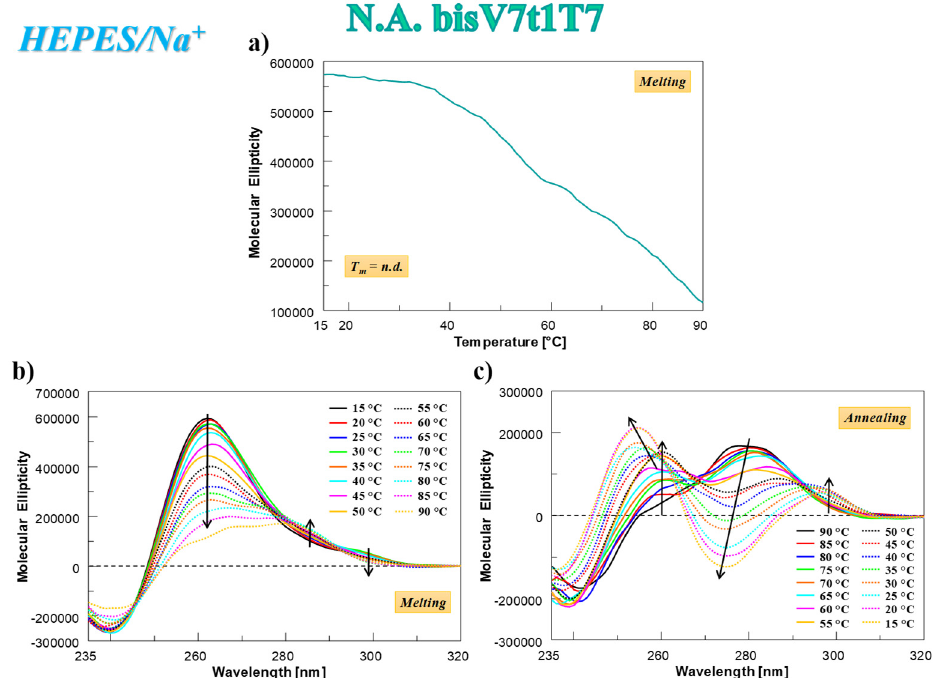
Figure 4. N.A. bisV7t1T7 at 2 μ M concentration in the selected HEPES/Na + buffer: ( a ) CD-melting profile, recorded at 262 nm using a scan rate of 1 °C/min; ( b , c ) overlapped CD spectra recorded every 5 °C during the melting ( b ) and cooling processes ( c ). Arrows in panels b and c indicate the evolution of the CD signal over time. n.d. = not determined.